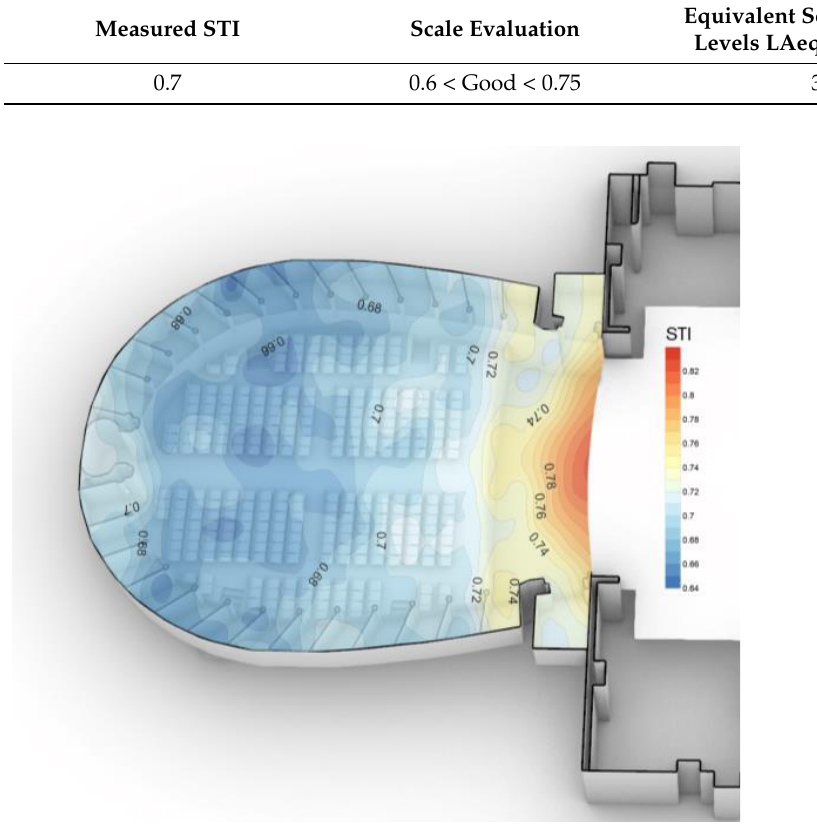
Figure 7. Spatial distribution of speech transmission index (STI) inside the Ponchielli theater of Cremona.